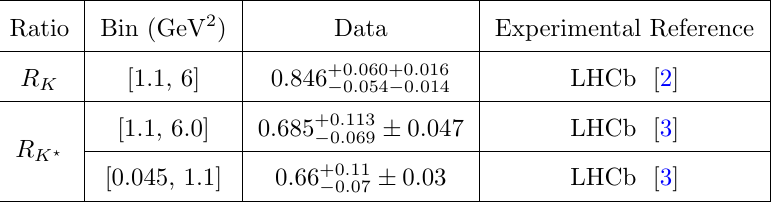
Table 1 . R as measured by the LHCb collaboration. Also see footnote K ( ? )